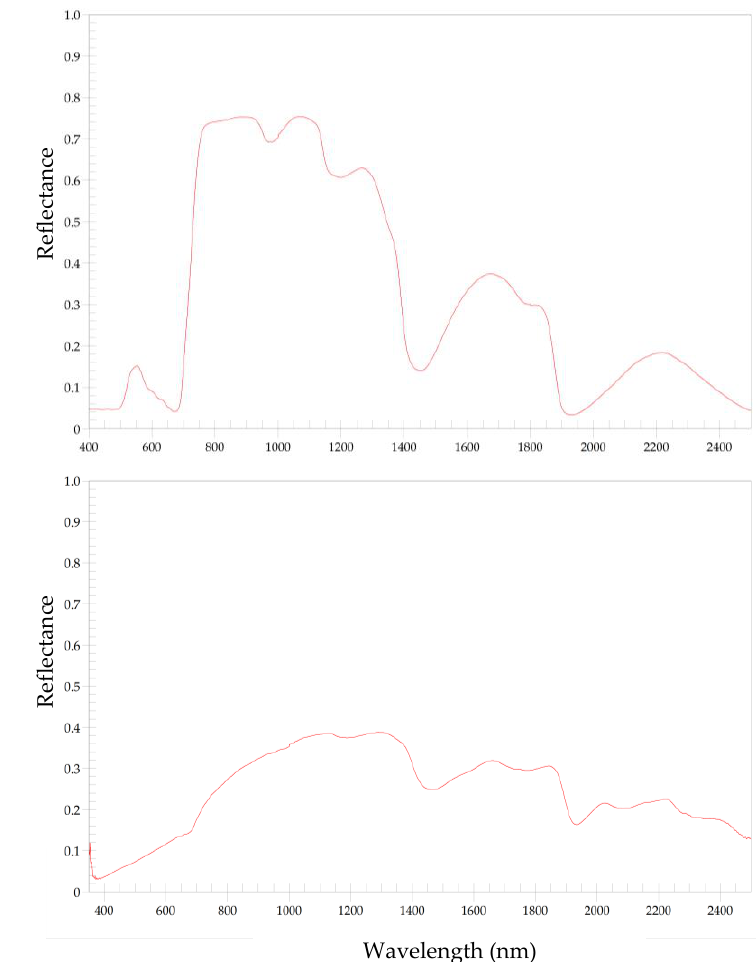
Figure 4. The spectral reflectance of a perennial ryegrass breeding plot, ( a ) before and ( b ) after the destructive harvest, where the spectra were generated using the ASD FieldSpec ® HiRes 4 hyperspectral data with no derivatives.